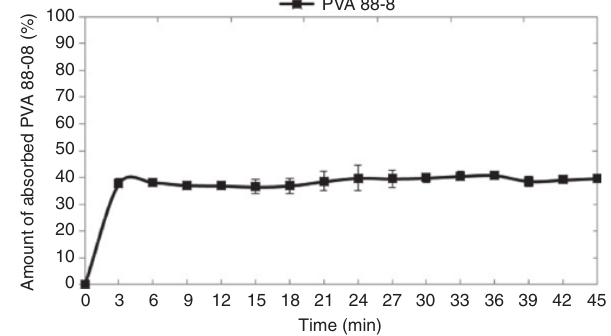
Figure 1: The respiration of microorganisms of the activated sludge in the presence of clay minerals ( ± standard deviation); standard – endogenous respiration.